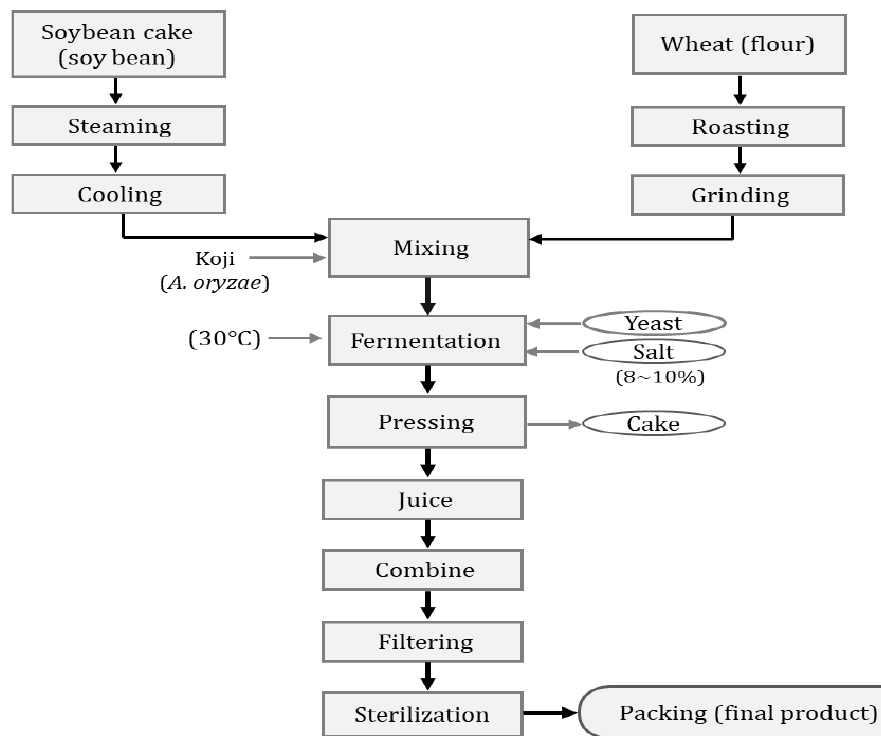
Figure 5. Manufacturing process of modified ganjang.